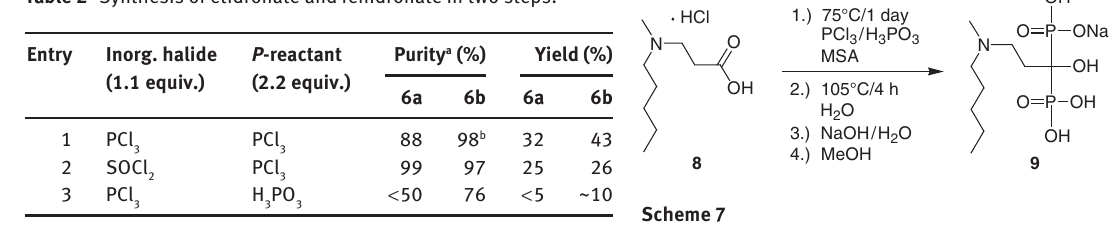
Table 2 Synthesis of etidronate and fenidronate in two steps.